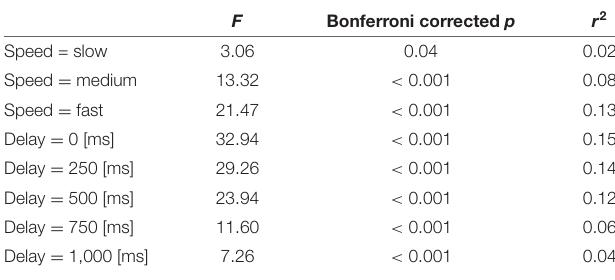
TABLE 4 | Simple main effects of delay and speed on stiffness